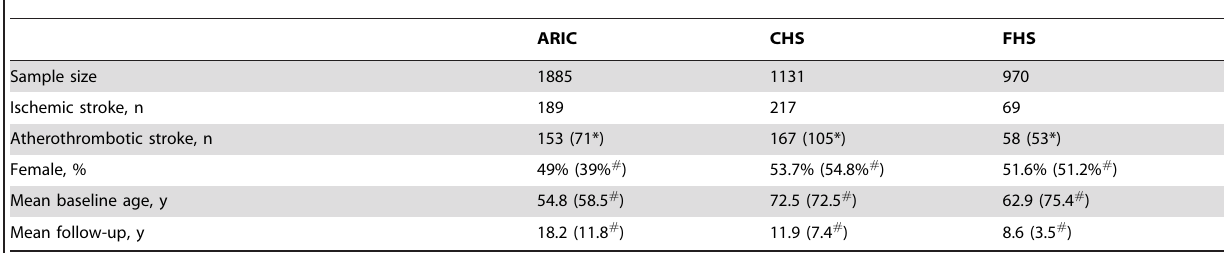
Table 1. Characteristics of study participants.